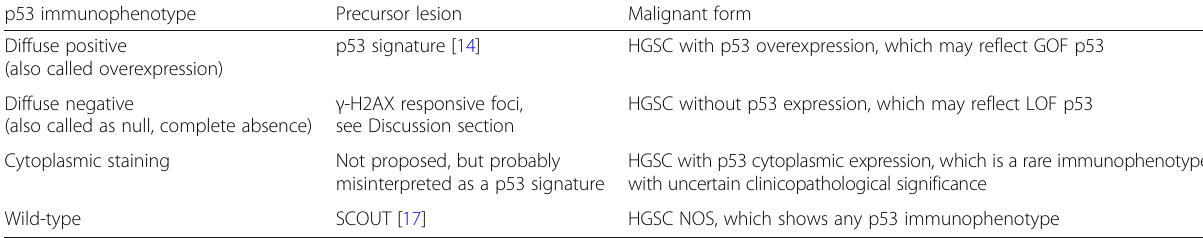
Table 1 Summary of relationship between high-grade serous carcinogenesis and p53 immunophenotype p53